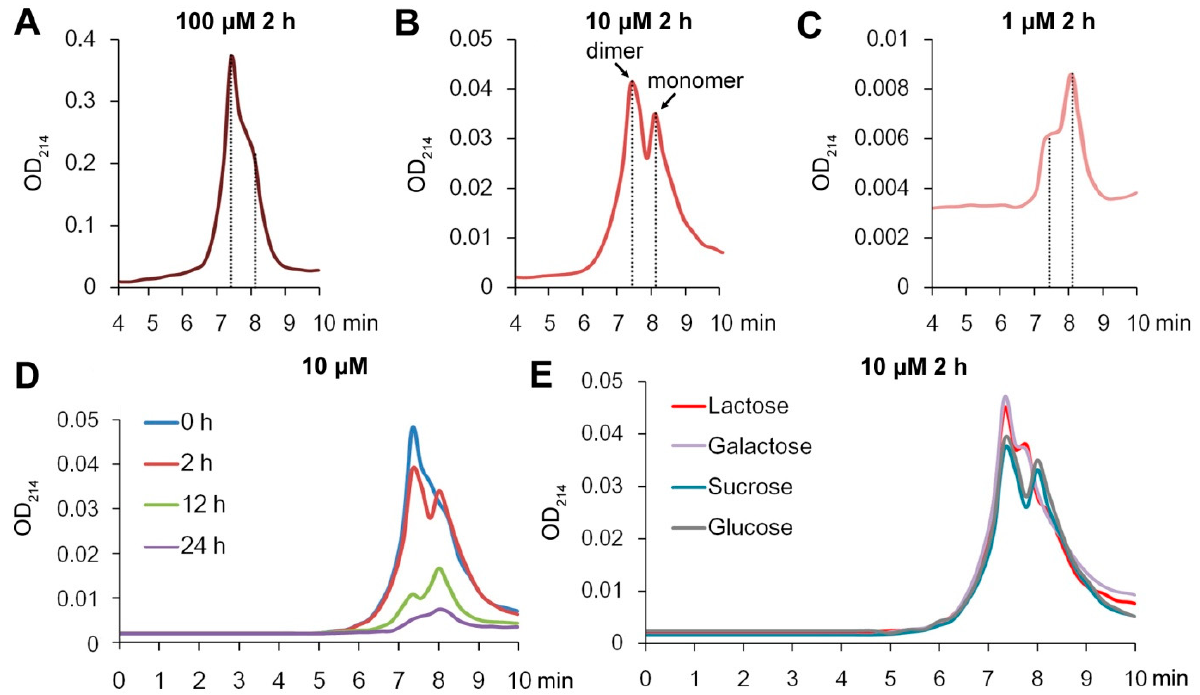
Figure 1. Concentration-dependent and time-dependent dimer formation of Gal-10 and the effects of carbohydrate binding. ( A – C ) Concentration-dependent dimerization of Gal-10. The protein was diluted to 100 μ M, 10 μ M, and 1 μ M and incubated for 2 h. ( D ) Time-dependent dimer formation of Gal-10. The protein was diluted to 10 μ M and incubated for 0 h, 2 h, 12 h, and 24 h. ( E ) Effects of sugars on Gal-10 monomer–dimer equilibrium. Gal-10 was diluted to 10 μ M and incubated with 1 mM lactose, galactose, sucrose, or glucose for 2 h. The samples were analyzed by SEC HPLC using PBS–azide buffer (pH 7.4).